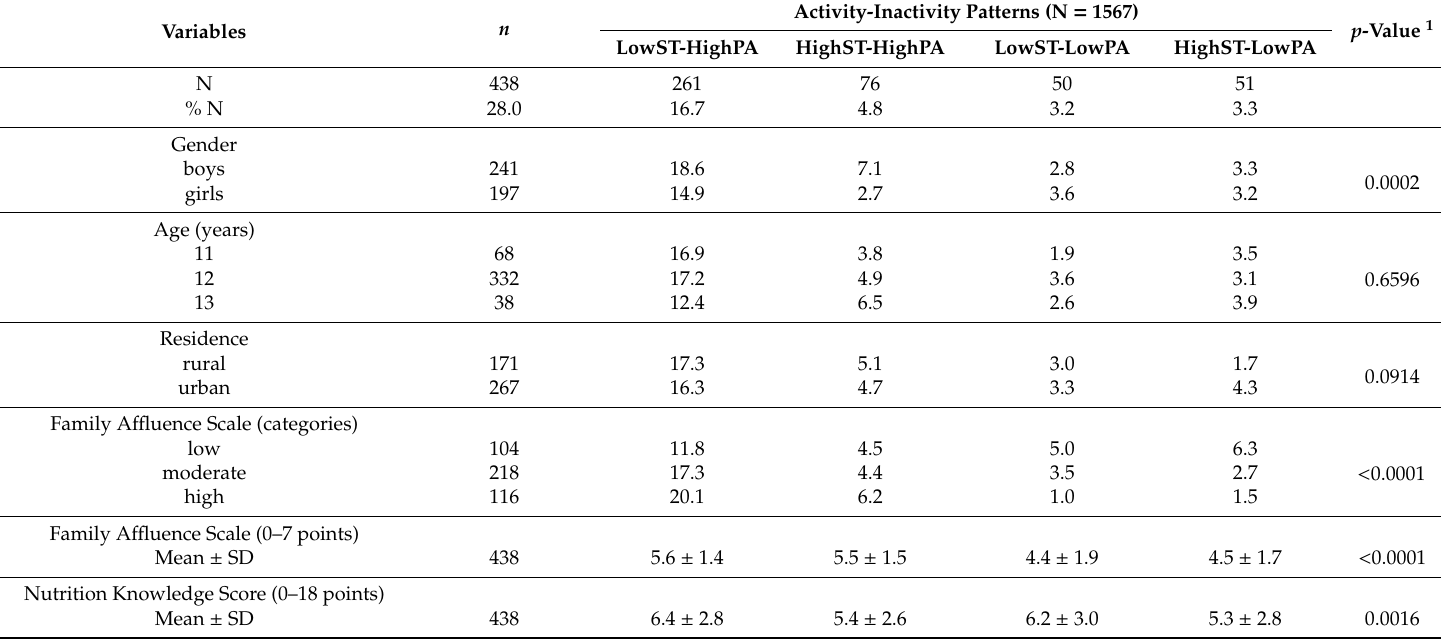
Table 3. Activity–inactivity patterns in participants by variables (% N or mean ±